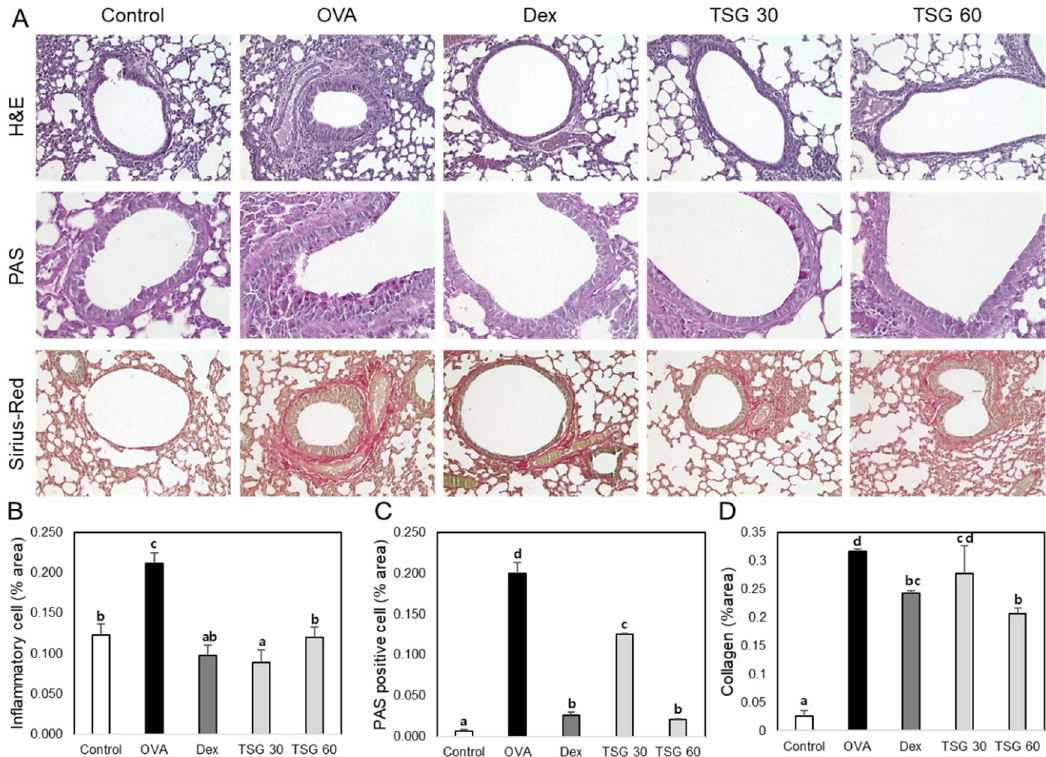
Figure 6. The effect of TSG on the histology of lung tissue in the OVA-induced murine model of asthma. The C57BL/6 mice were sensitized and challenged with OVA for asthma induction. At the end of the experiment, the mice lungs were removed. ( A ) The lungs were stained by H&E ( × 200), PAS ( × 400), and Picro Sirius Red ( × 200). The percentages of ( B ) inflammatory cells, ( C ) PAS-positive cells, and ( D ) collagen in the lung sections were measured via Image J program. The data represent three mice per group. All data were expressed as means ± SD. a, b, c, and d: The means not sharing a common letter are significantly different between groups at p < 0.05 as measured by one-way ANOVA with Duncan’s multiple-range test.